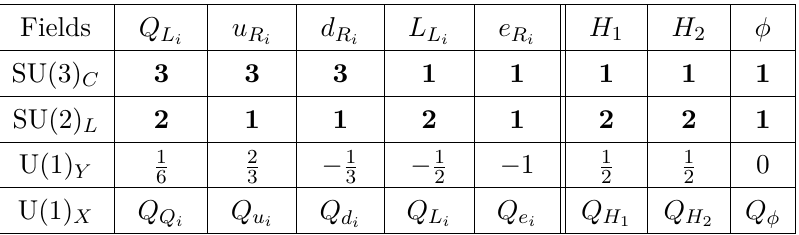
Table 1 . Charge assignments for SM fermions under gauge symmetry including extra U(1) X . sector we introduce the SM singlet φ which develops vacuum expectation value(VEV), v to break U(1) gauge symmetry. The Higgs doublets and singlet scalar are represented X